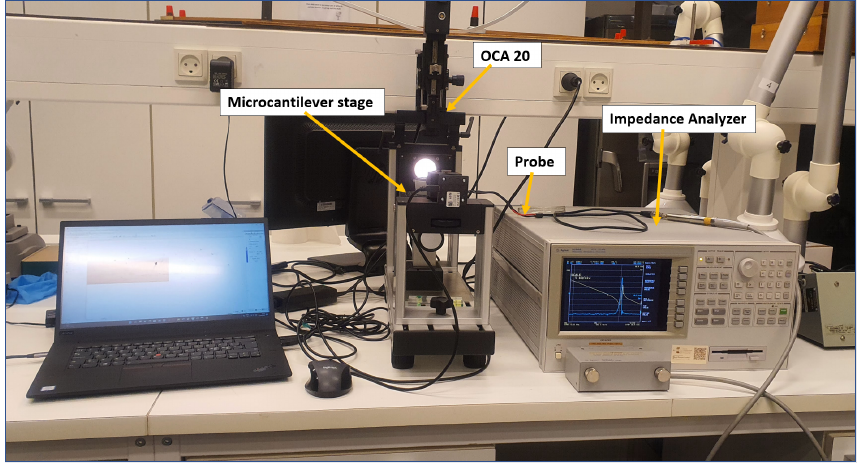
Figure 3. The set-up used for the calibrating microcantilever response to mass